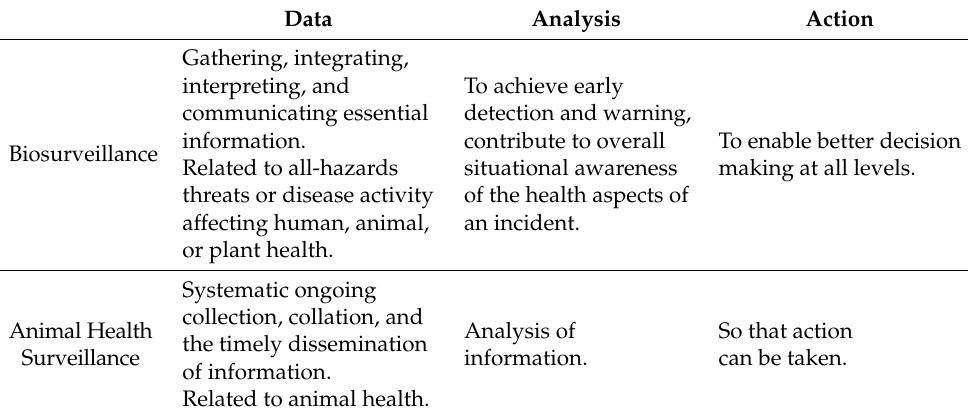
Table 1. Comparison of definitions of biosurveillance and animal health surveillance [4,8] .